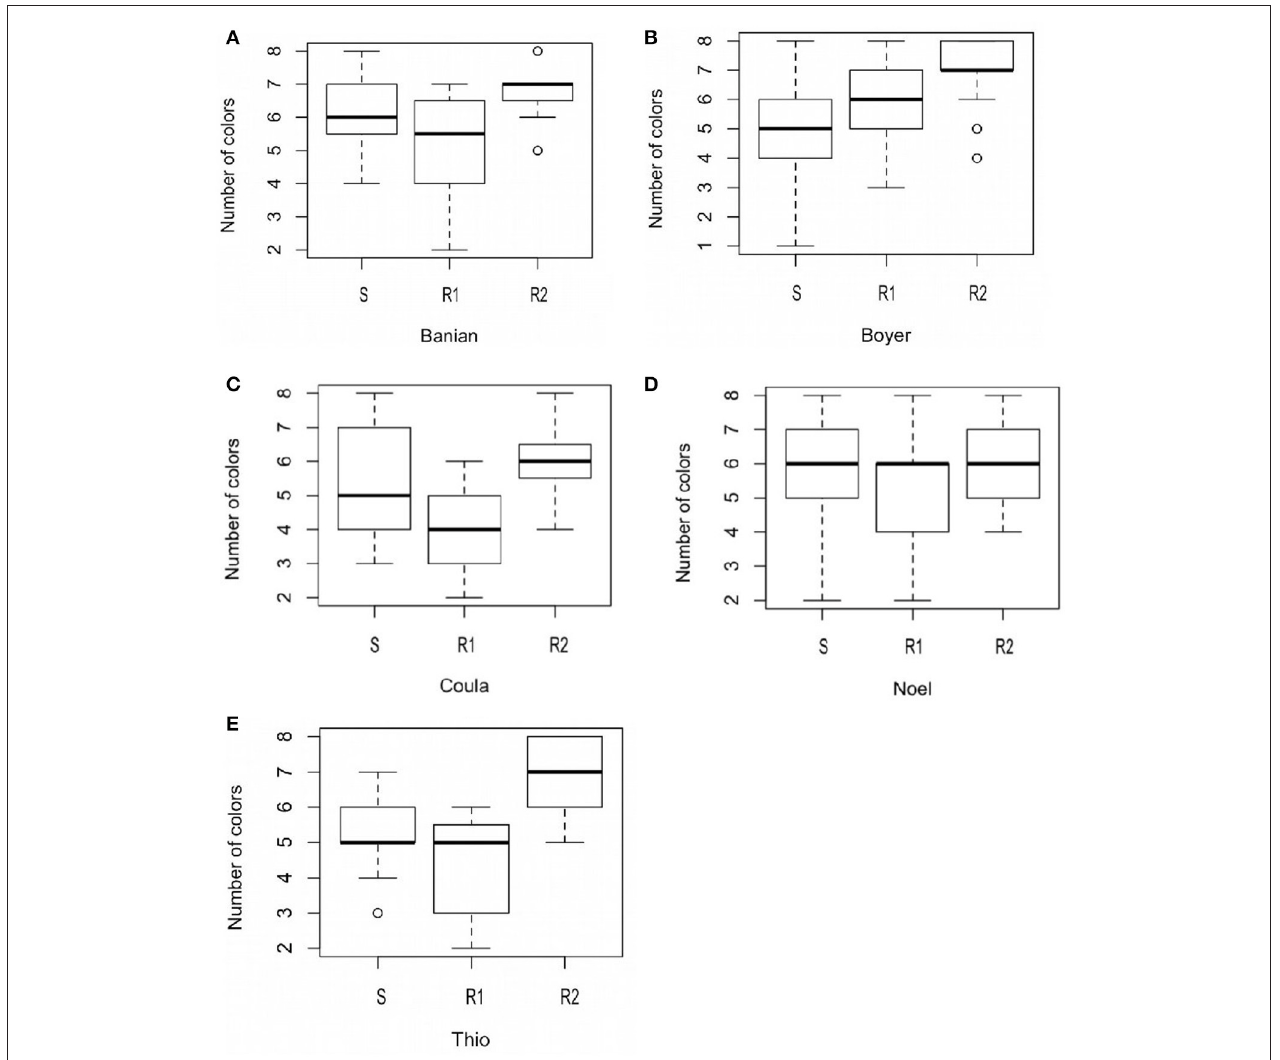
FIGURE 6 | Quantile’s box plot of the number of colors used in the drawings between Sea, Reef1 and Reef2 per school. (A) Banian (coastal area within a large fishing community), (B) Boyer (socially advantaged urban neighborhood), (C) Coula (rural environment), (D) Noell (l less advantaged urban neighborhood), (E) Thio (coastal area close to a marine